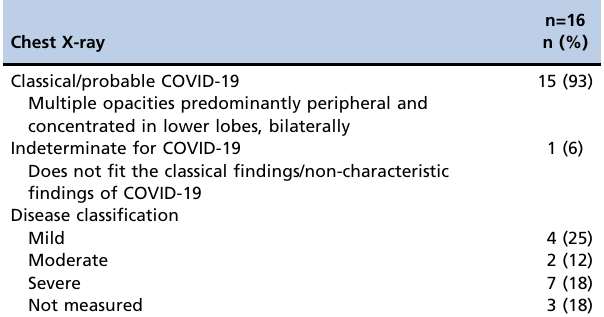
Table 3 - Radiographic